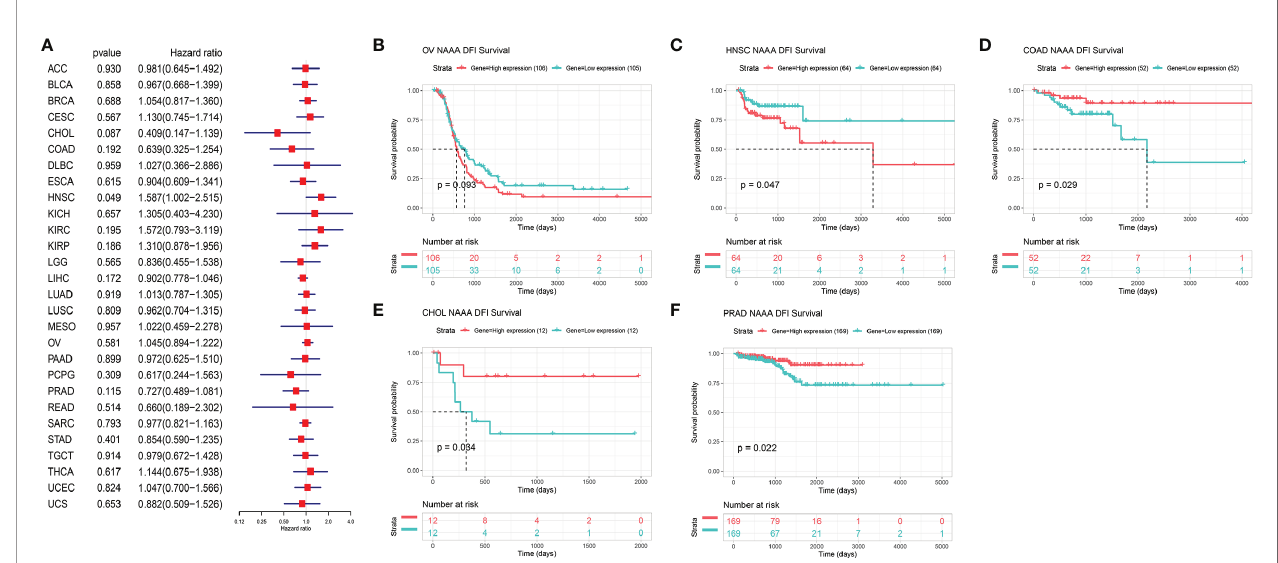
FIGURE 5 | Relationship of NAAA expression with patient Disease-Free Interval (DFI). (A) Forest map shows the univariate Cox regression analysis results for NAAA in TCGA pan-cancer samples. (B – F) Kaplan – Meier DFI curves of NAAA expression in the fi ve most signi fi cantly associated